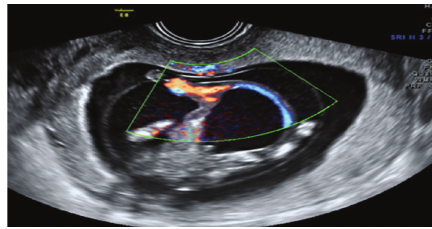
Figure 7: Short umbilical cord with herniation of abdominal contents including urinary